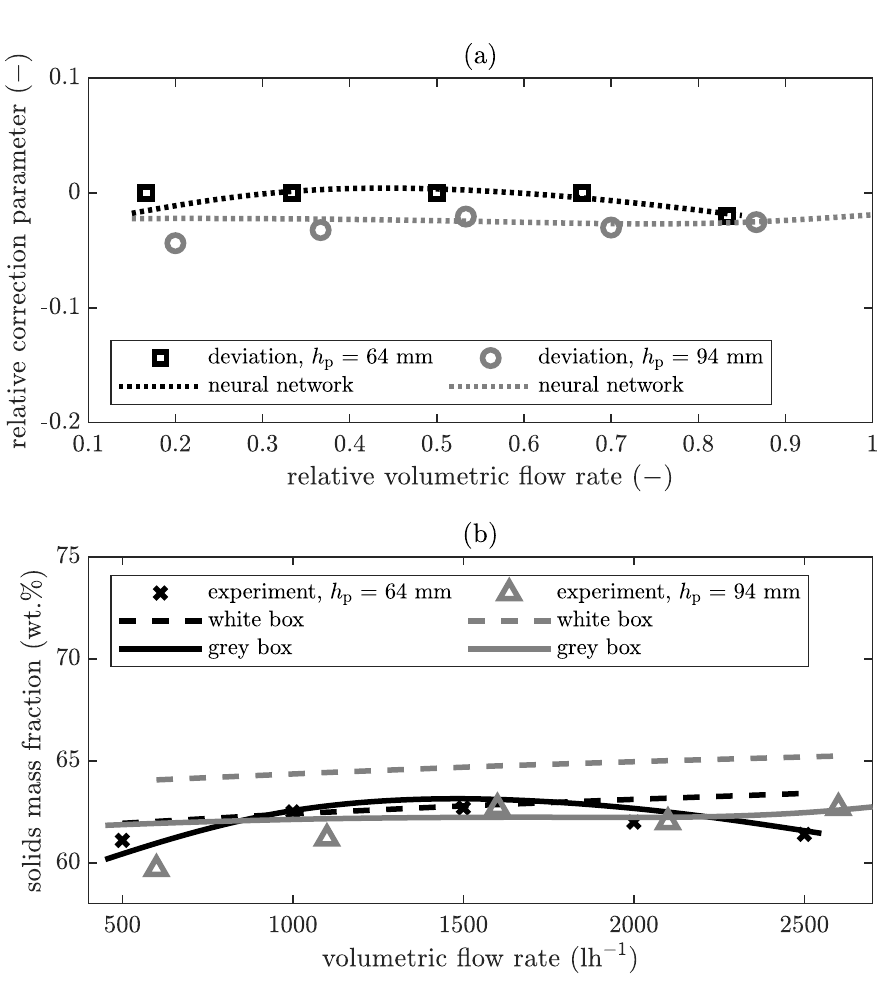
Figure 9. Solids mass fraction of the cake at a constant rotational speed of n rot = 2950rpm for the product CC2: ( a ) relativised output of the black box model, ( b ) comparison of the results from experiment, white, and grey box